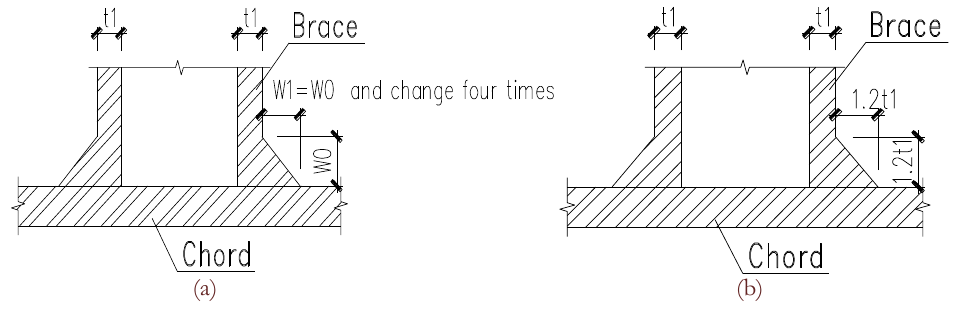
Figure 2: Finite-element model of Zheng